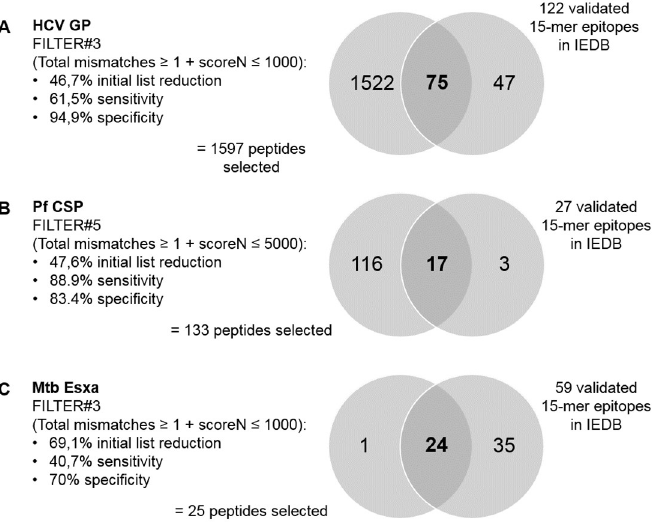
Fig 4. Sensitivity and specificity of example filters applied to final HLA-class II results table from SILVI.